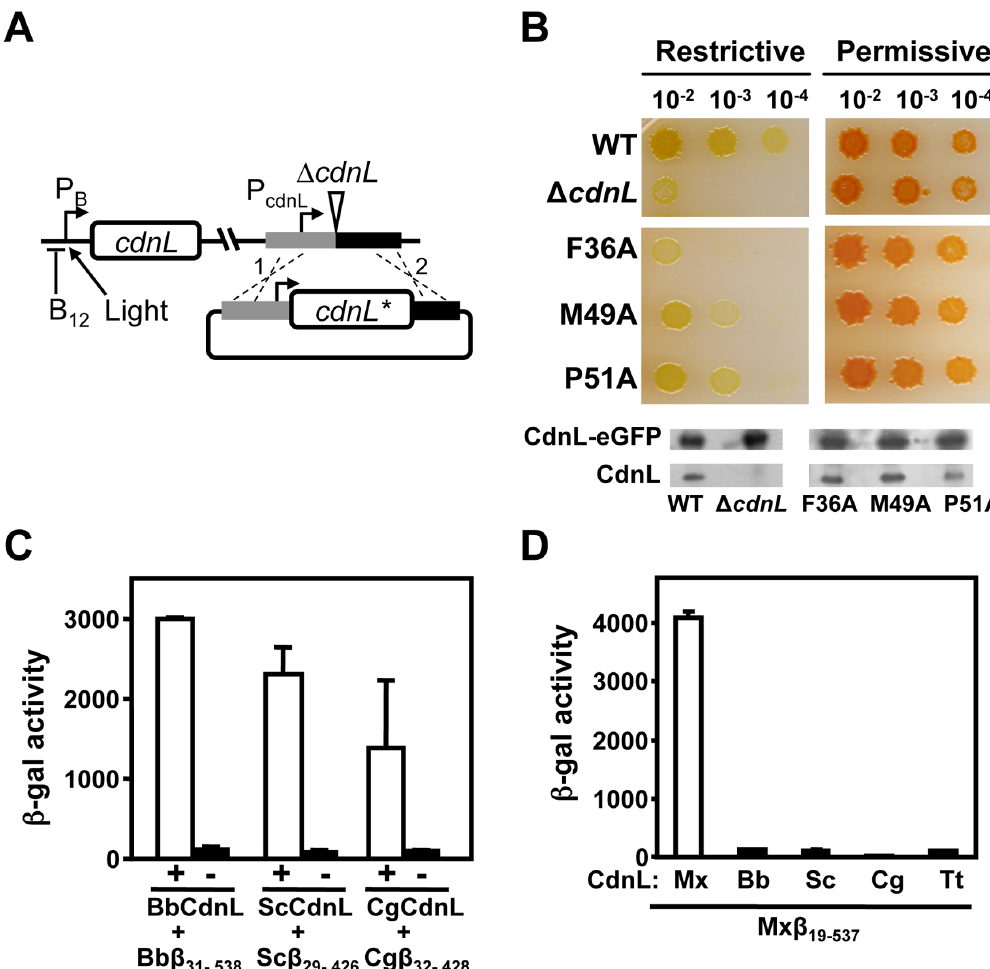
Figure 5. Consequences of disrupting CdnL interaction with RNAP invivo . ( A ) Scheme of the strategy employed to check for cdnL complementation in M. xanthus. A pMR2873 construct with the required cdnL allele ( cdnL *) under P cdnL control and DNA segments flanking cdnL upstream (grey) and downstream (black) in the genome, was introduced into strain MR1467, which bears the D cdnL allele and a copy of cdnL at a heterologous site under the control of the photoinducible P B promoter (expressed in the light but repressed in the presence of B 12 in the dark). Merodiploids resulting from plasmid integration by recombination at either ‘‘1’’ or ‘‘2’’ would constitutively express cdnL * from P cdnL and conditionally express the wild-type allele from P B at a heterologous site. ( B ) Complementation analyses in M. xanthus with the F36A, M49A and P51A CdnL mutants. CTT/B 12 plates that were spotted with 5 m l of liquid cultures (OD 550 , 1) grown under permissive conditions and diluted as indicated, and then incubated for 2 days at 33 u C under restrictive (dark and B 12 ) or permissive (light, hence the red color) conditions. ‘‘WT’’ is the positive control derived from using pMR2873 with wild-type cdnL , and ‘‘ D cdnL ’’ is the recipient strain MR1467. Western blots (using polyclonal anti-CdnL antibodies) of M. xanthus cell extracts from strains expressing each CdnL variant and in which CdnL-eGFP supplied the essential CdnL function, as described in the text. ( C ) BACTH analysis of the interaction of CdnL homologs (BbCdnL, ScCdnL, and CgCdnL) with Bb b 31–538 , Sc b 29–426 , and Cg b 32–428 fragments, respectively. ‘‘ + ’’ below the open bars indicates that both members of the pair are present, while ‘‘ 2 ’’ is the negative control (without the indicated CdnL homolog). We have shown the interaction of TtCdnL with its cognate b -fragment elsewhere [18]. ( D ) BACTH analysis of the interaction of BbCdnL, ScCdnL, CgCdnL or TtCdnL with M. xanthus Mx b 19–537